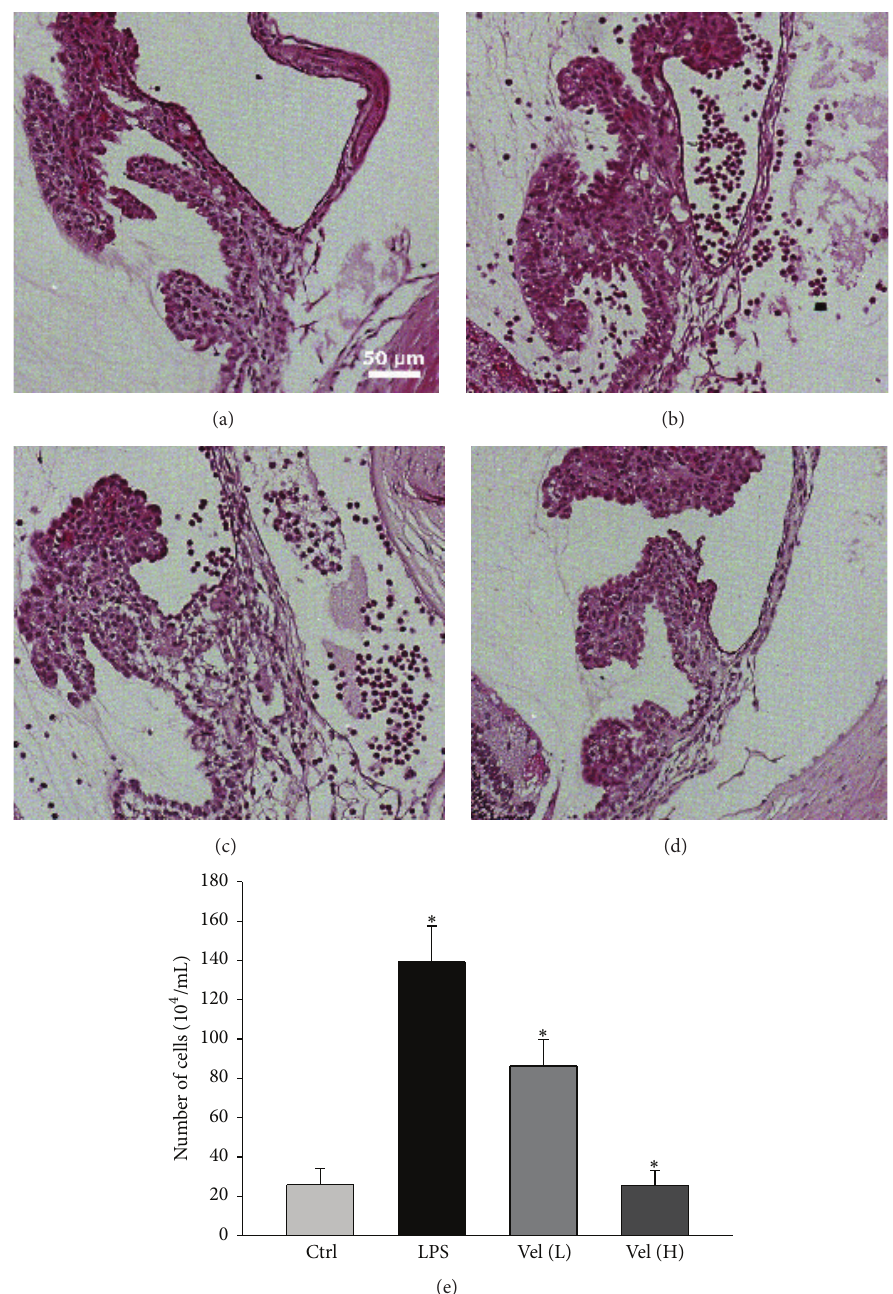
Figure 1: Histological evaluation of cellular infiltration into the iris and ciliary bodies. Vel (L) = low-dose bortezomib, Vel (H) = high-dose bortezomib; inflammatory cell infiltration can be observed in the ciliary bodies of (b) LPS only and (c) low-dose bortezomib-treated rat eyes but not in (a) the control and (d) high-dose bortezomib-treated groups. Scale bar = 50 𝜇 m. (e) Quantification of the infiltrating cells in the AqH. EIU rats pretreated with bortezomib showed significantly reduced cell numbers in the AqH in a dose-dependent manner. The AqH was pooled from one eye of five rats in each group. The data are expressed as the means ± SDs of three independent experiments (bar graph). ∗ 𝑝 < 0.05 compared with the control